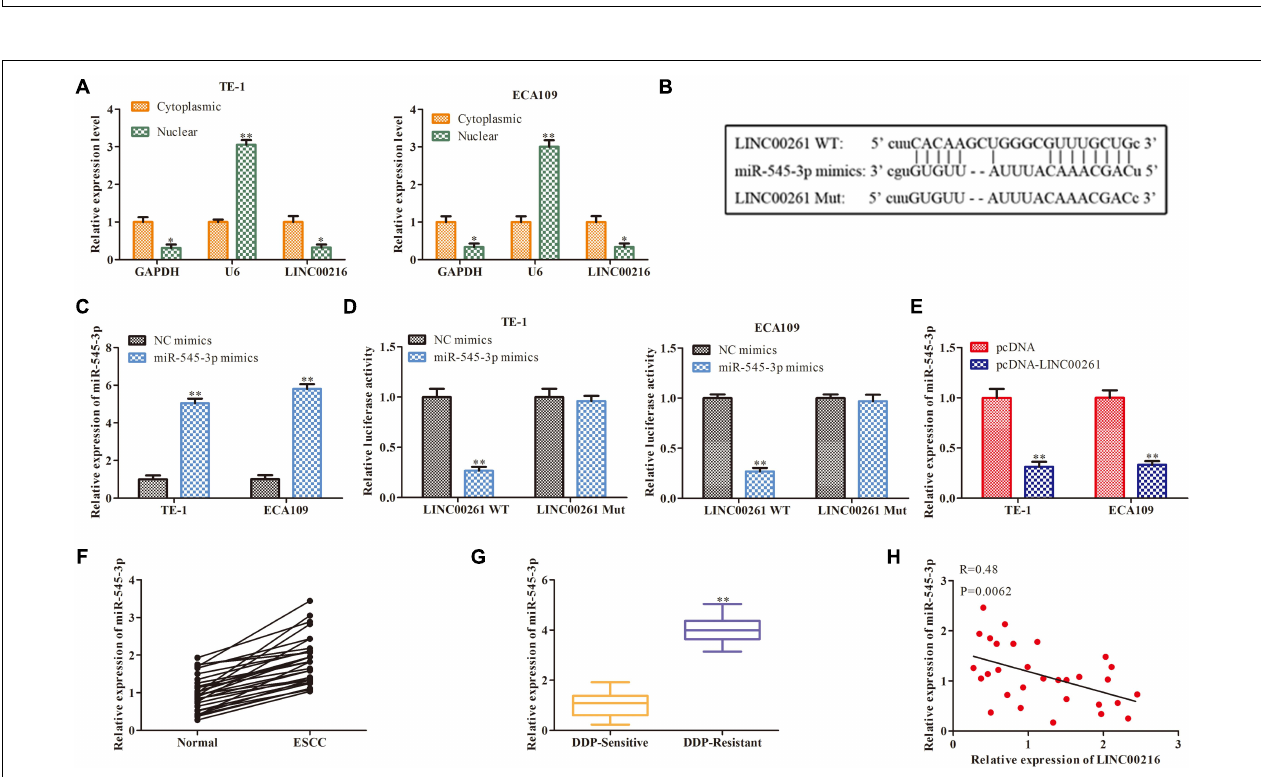
FIGURE 4 | LINC00261 functions as a molecular sponge for miR-545-3p. (A) The location of NEAT1. (B) The binding sits between LINC00261 and miR-545-3p predicted by Bioinformatics websites. (C) The mRNA level of miR-545-3p in NC-mimics group and miR-545-3p mimics group. (D) The relationship between LINC00261 and miR-545-3p verified by luciferase reporter assay. (D) The mRNA level of miR-766-5p in PCa tissues. (E) The mRNA level of miR-545-3p in pcDNA group and pcDNA-LINC00261 group. (F) The expression of miR-545-3p in ESCC tissues and adjacent tissues. (G) The expression of miR-545-3p in DDP-sensitive and DDP-resistant ESCC patients. (H) Pearson’s correlation analysis demonstrated the correlation of LINC00261expression with miR-545-3p. * P < 0.05, ** P < 0.01 compared with the corresponding control group.